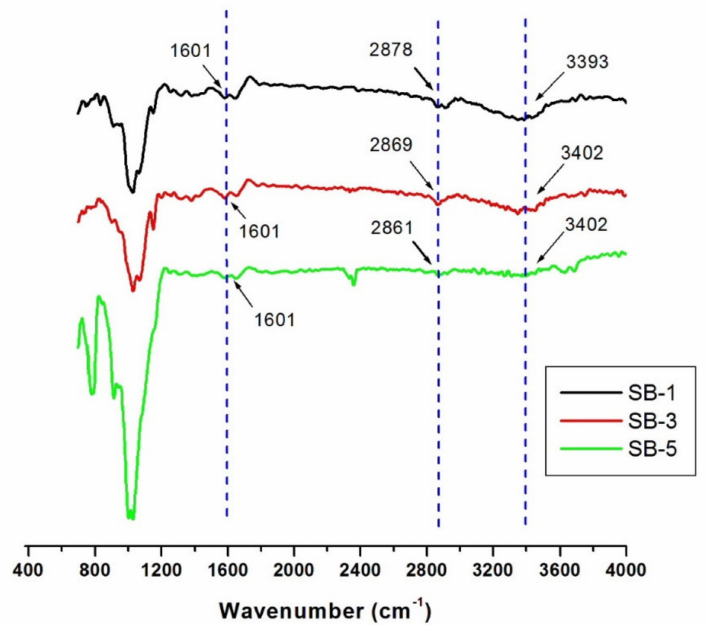
Figure 2. FTIR spectra of biocomposite beads SB-1, SB-3, and SB-5.Transmittance peaks at 1601 cm − 1 (N–H bending) and 3402 cm − 1 (O–H stretching overlapping the N–H stretching of the primary amine) indicate the presence of chitosan in the composite while the peak at 2900 cm − 1 (C–H stretching of dodecylamine) is due to the presence of MC. Peak intensities at 1601 cm − 1 and 3402 cm − 1 increase